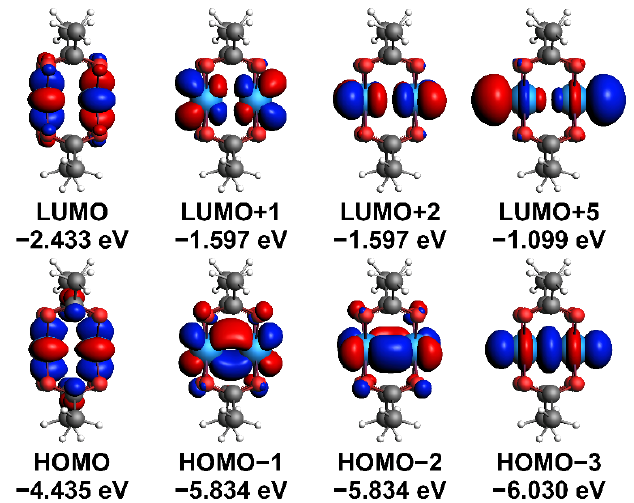
Figure 2. MOs (isosurface: 0.05 au) demonstrating bonding ( σ , π , δ ) and antibonding ( σ *, π *, δ *) interactions of Mo 4d orbitals for the optimized DMT structure. The digits in parentheses are the MO energies in eV.